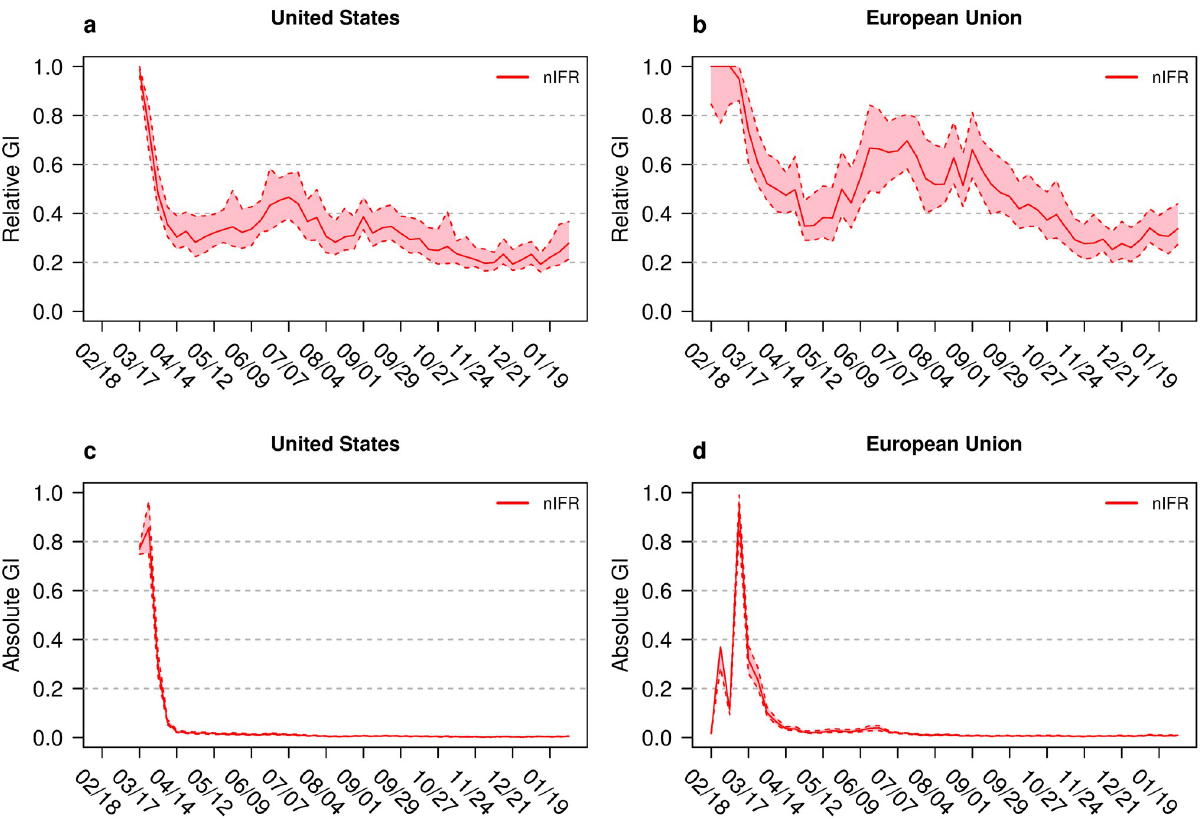
Fig 5. Gini indices for naive infection fatality rate nIFR for theUnited States and the European Union. Gini indices (GI) for the states of the United States (left column) and member states of the European Union (right column). Shown are the relative GIs of nIFR (a and b) and absolute GIs of nIFR (c and d). The coloured bands show the 95% confidence intervals. The horizontal axis shows the time between February 2020 and February 2021.